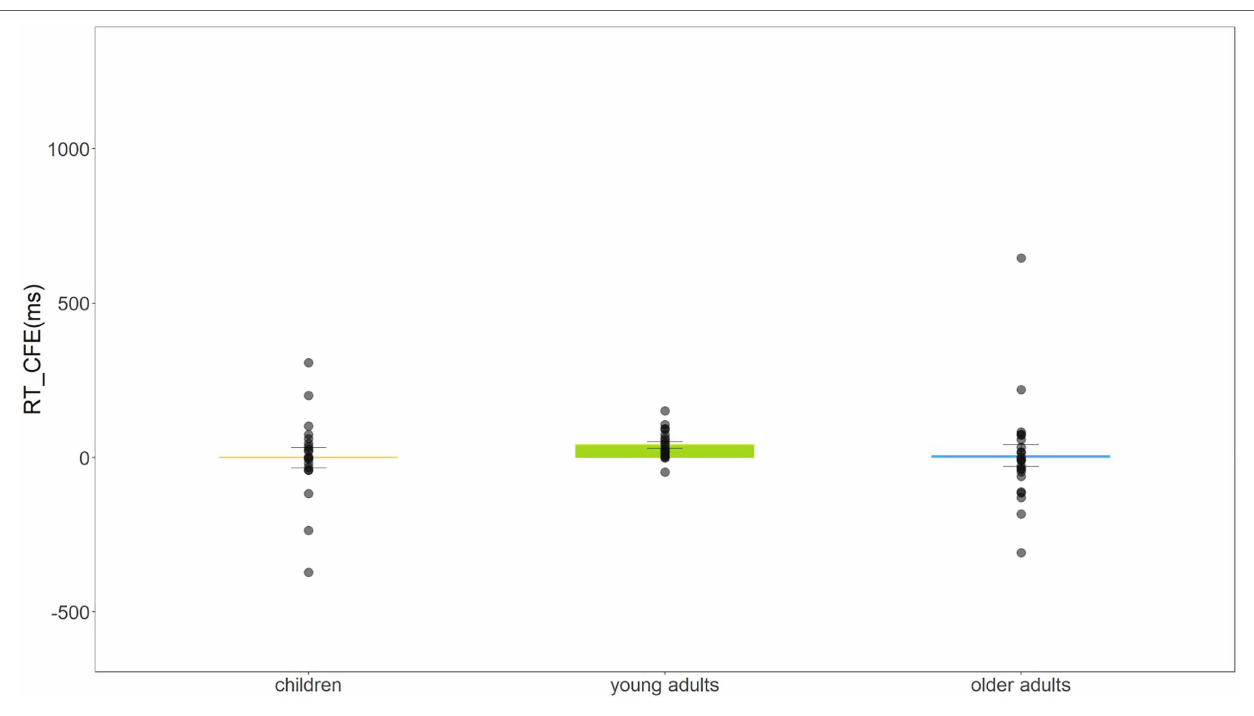
FIGURE 5 | Bar plot with data of CFERT (RT aligned congruent – RT aligned incongruent ) – (RT misaligned congruent – RT misaligned incongruent ) and standard errors of children, young adults, and older adults. The bar plot in the figure showed the mean size of CFERT of each group, and the black dots were the original data distribution of each